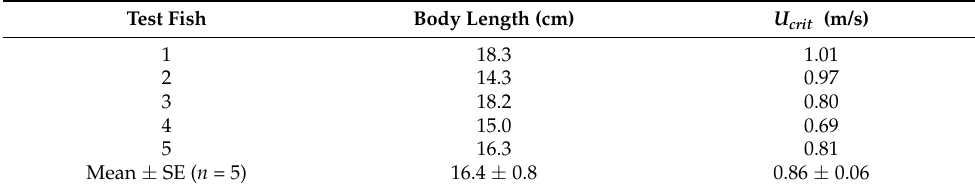
Table 3. Body Length and U crit for each test fish.